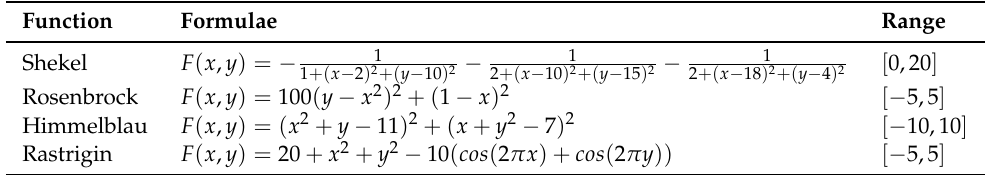
Table 1. Benchmark